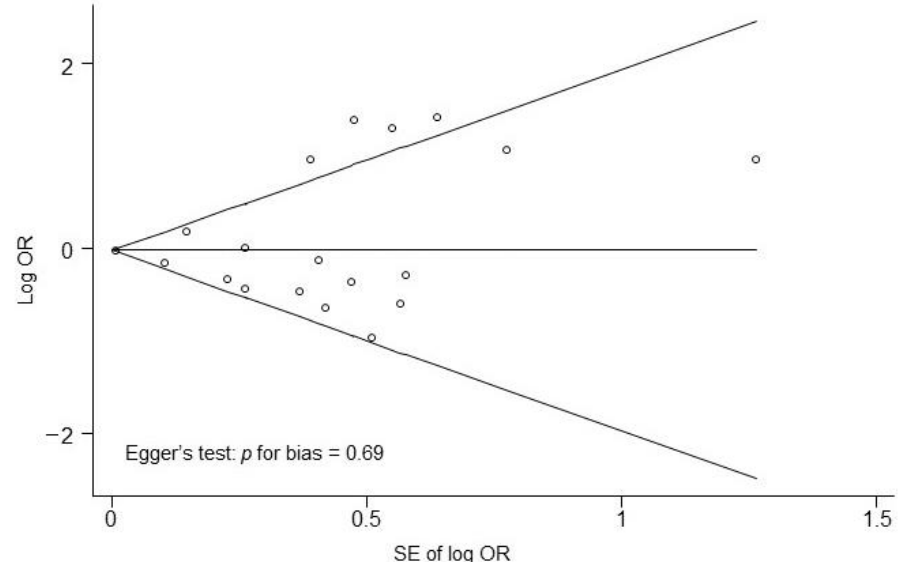
Figure 4. Funnel plots for identifying publication bias in the meta-analysis of observational studies.